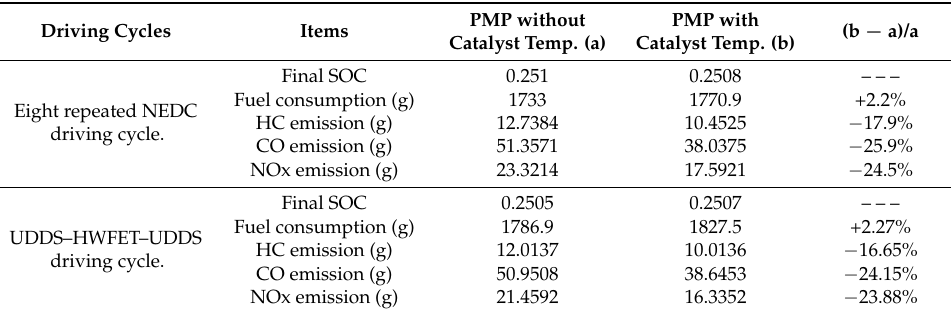
Figure 18. Engine working points under different EMS for UDDS–HWFET–UDDS driving cycle. Table 5. Vehicle’s fuel consumption and tailpipe emissions under different EMSs for eight repeated NEDC cycles and UDDS–HWFET–UDDS driving cycle.